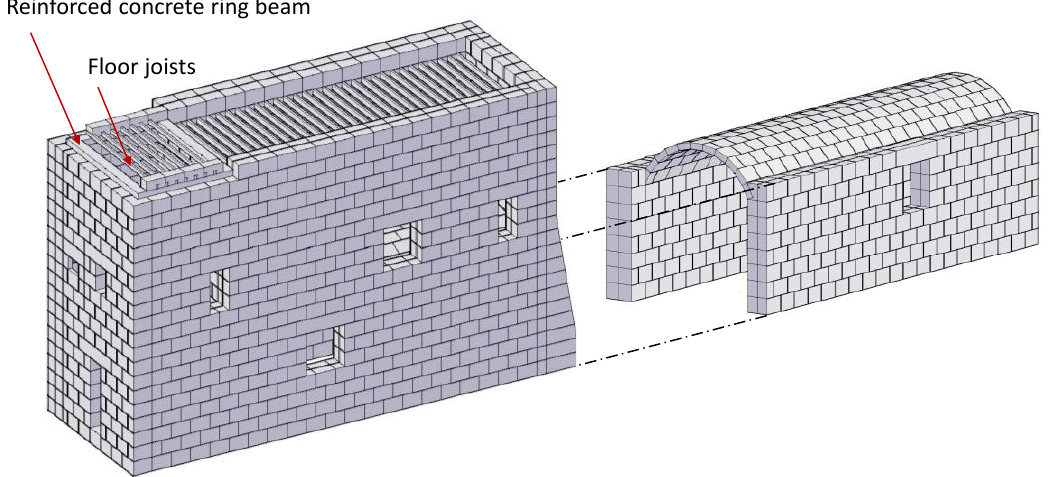
Figure 7. Details of the rigid block model.